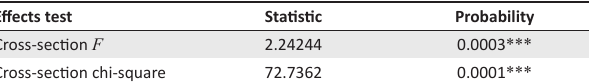
TABLE 5: Redundant fixed effects test.